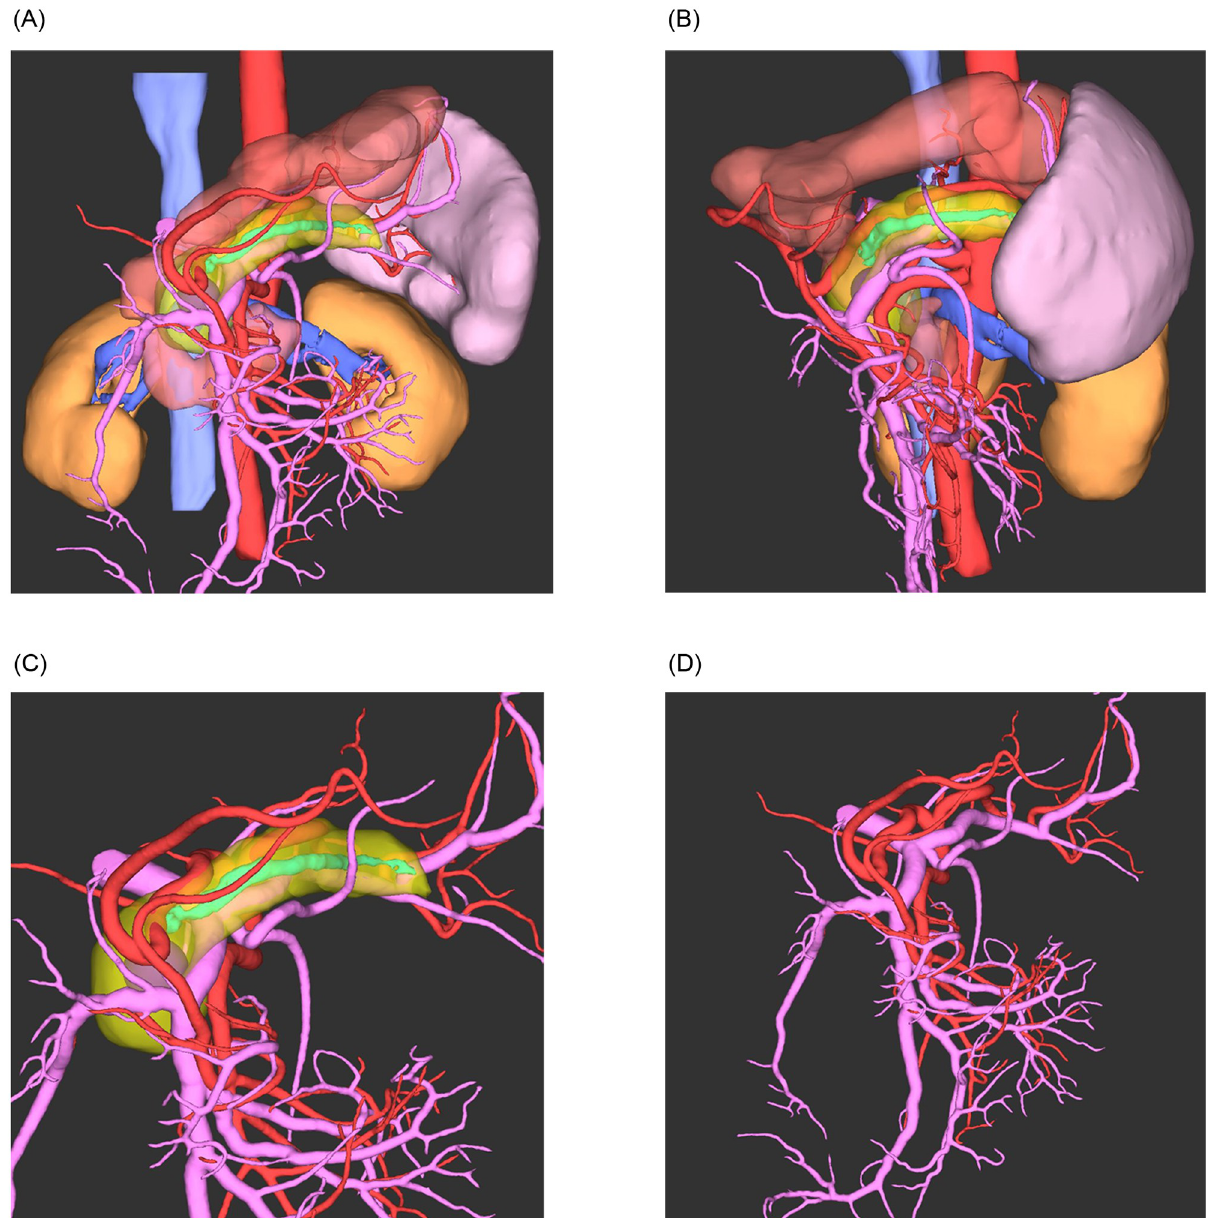
Fig 2. A three-dimensional (3D) image from a pancreatic cancer patient. The red color represents the arteries; pink represents the veins, including the portal vein; yellow represents the pancreas; turquoise represents the pancreatic duct; blue represents the renal vein and inferior vena cava; dark yellow represents the kidney; light pink represents the spleen; copper represents the stomach and duodenum; and dark pink represents the pancreatic tumor. A This view is an anterior 3D image. B This view is a left-sided lateral 3D image. C This view is an anterior 3D image only with pancreas, pancreatic duct, peripancreatic vessels including the artery and veins including the portal vein, and pancreatic tumor. D This view is an anterior 3D image only with the peripancreatic vessels, including the artery and veins including the portal vein.